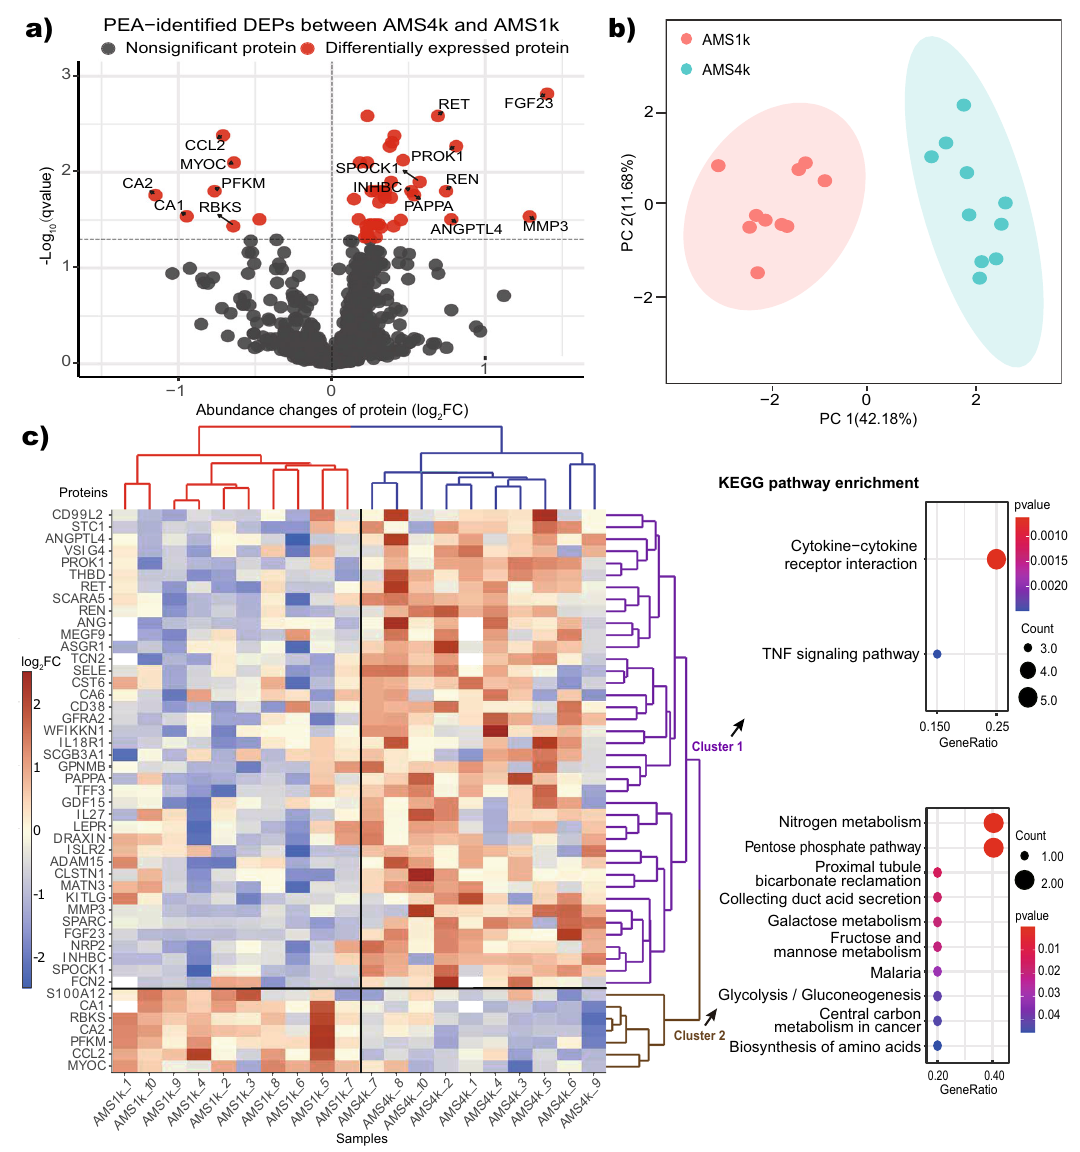
Fig. 2 PEA-identi fi ed proteins and biological functions involved in AMS. a Volcano plot of PEA-identi fi ed DEPs between the AMS4k ( n = 10) and AMS1k ( n = 10) groups. Proteins with no statistical signi fi cance ( q value ≥ 0.05, gray dots) and DEPs ( q value < 0.05, red dots) with absolute value of log 2 FC larger than 0.5 are labeled with gene symbols. b PCA plot based on PEA-identi fi ed DEPs. The AMS1k (light red dots) and AMS4k (sky-blue dots) samples were well separated by PCA using the PEA-identi fi ed DEPs without missing values ( n = 42). c Abundance heatmap and KEGG pathway enrichment diagram of the PEA-identi fi ed DEPs. The scaled abundance heatmap of DEPs between the AMS4k and AMS1k groups per sample is shown on the left side. The hierarchical cluster analysis in the heatmap showed that the 47 DEPs could clearly distinguish the AMS4k group (red hierarchical tree) and AMS1k group (blue hierarchical tree), and the DEPs could be separated into cluster 1 (purple hierarchical tree) and cluster 2 (brown hierarchical tree). Dot plots of the KEGG enrichment of the two clusters with p values < 0.05 are presented on the right side. Cytokine – cytokine receptor interactions and the TNF signaling pathway were enriched in cluster 1 (purple fonts), and nitrogen metabolism and the pentose phosphate pathway were mainly enriched in cluster 2 (brown